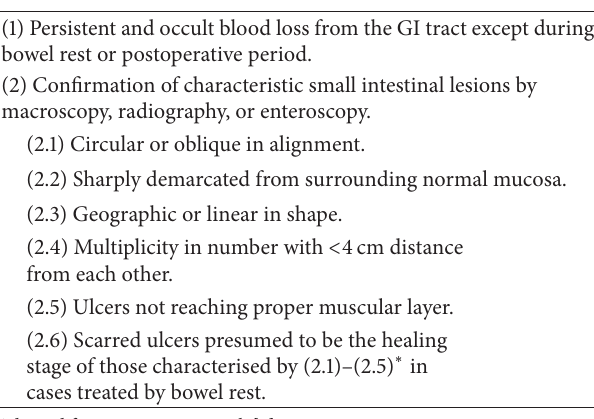
Table 2: Differentiation of CMUSE from Crohn’s disease. Absence of clinical or laboratory features of an inflammatory syndrome Absence of small intestinal transmural inflammatory process or ulceration Absence of small intestinal giant-cell granulomatous inflammatory process Absence of small intestinal fistula formation despite recurrent chronic disease Absence of disease in other parts of gastrointestinal tract (i.e., stomach or colon) Absence of most extraintestinal features of Crohn’s disease (e.g., skin